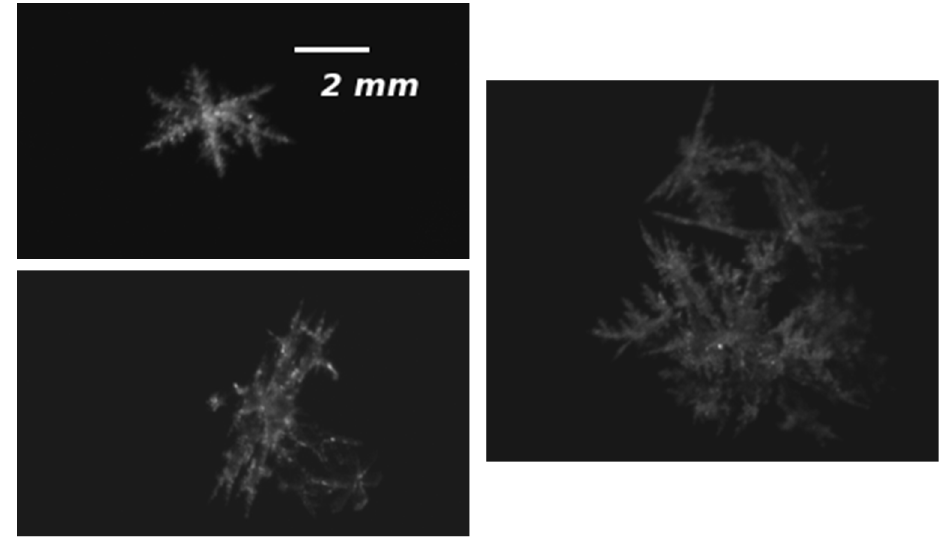
Figure 36. Selected MASC images between 18:33 and 18:38 UTC on 3 March 2015.